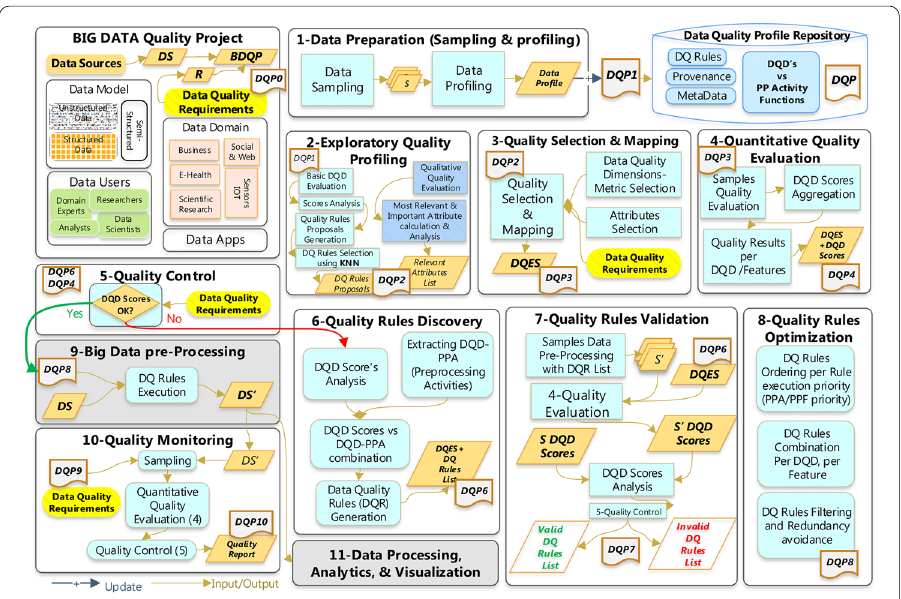
Fig. 4 Big data quality management